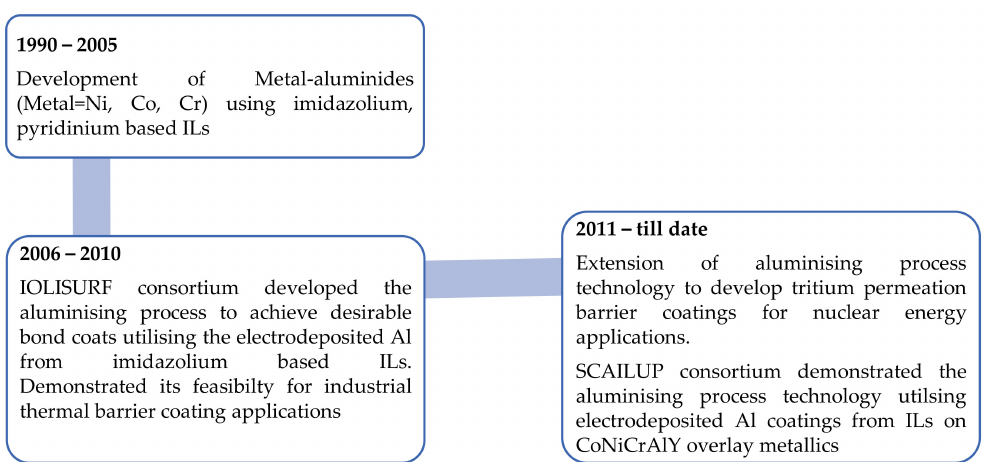
Figure 3. The schematic of the developments associated with aluminide coatings utilising the electrodeposited Al from ionic